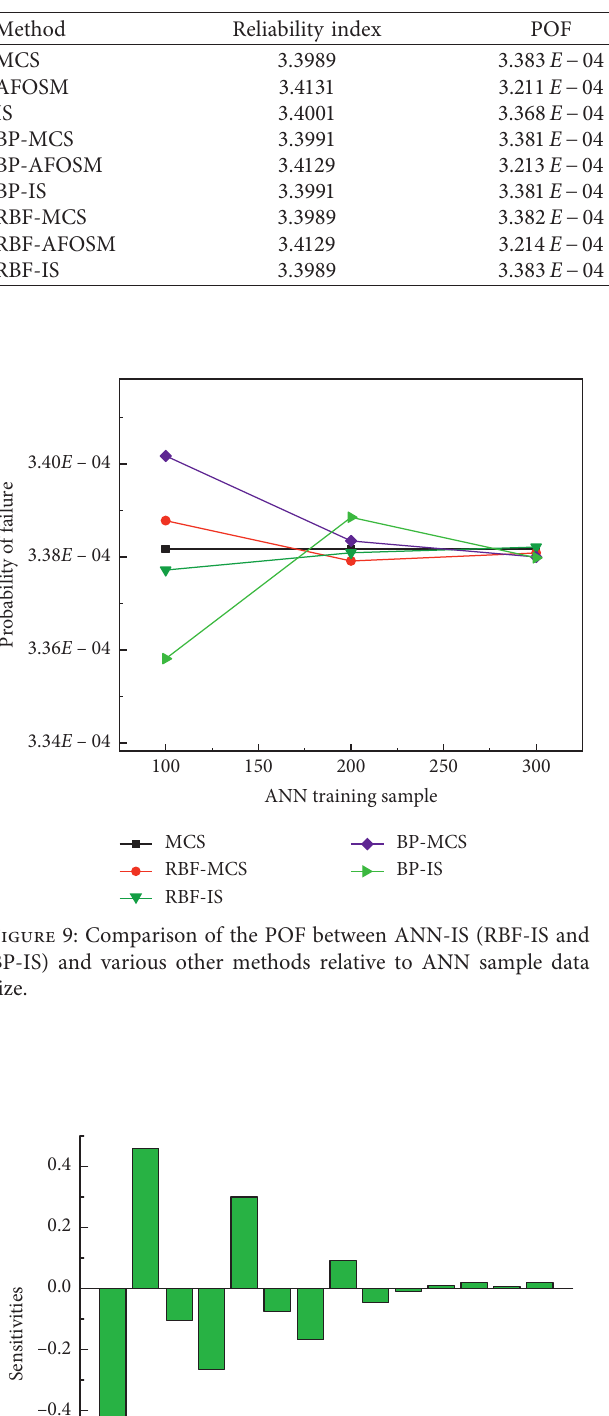
Table 7: Comparison of the reliability index and POF from different reliability analysis methods with an ANN sample size of 300.